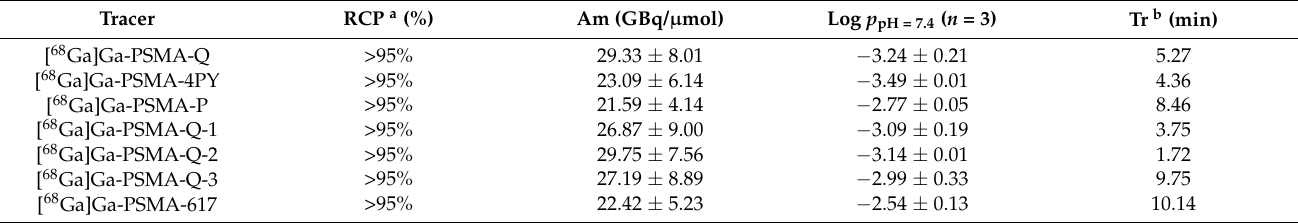
Table 1. Analytical data of the prepared